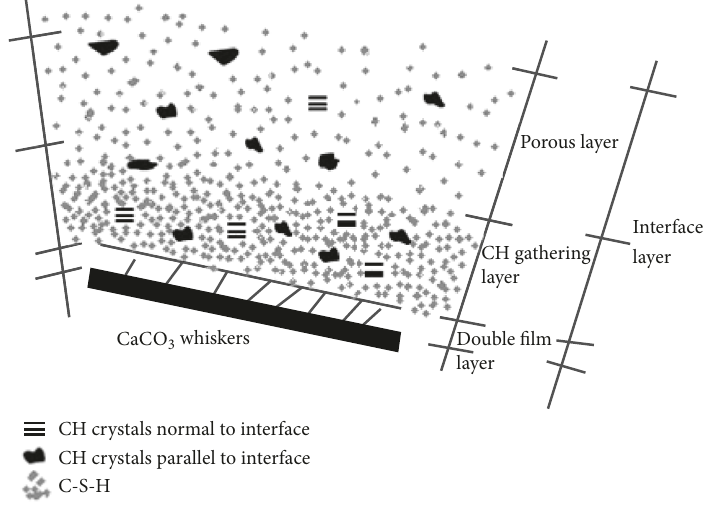
Figure 21: Physical model of interface layer.